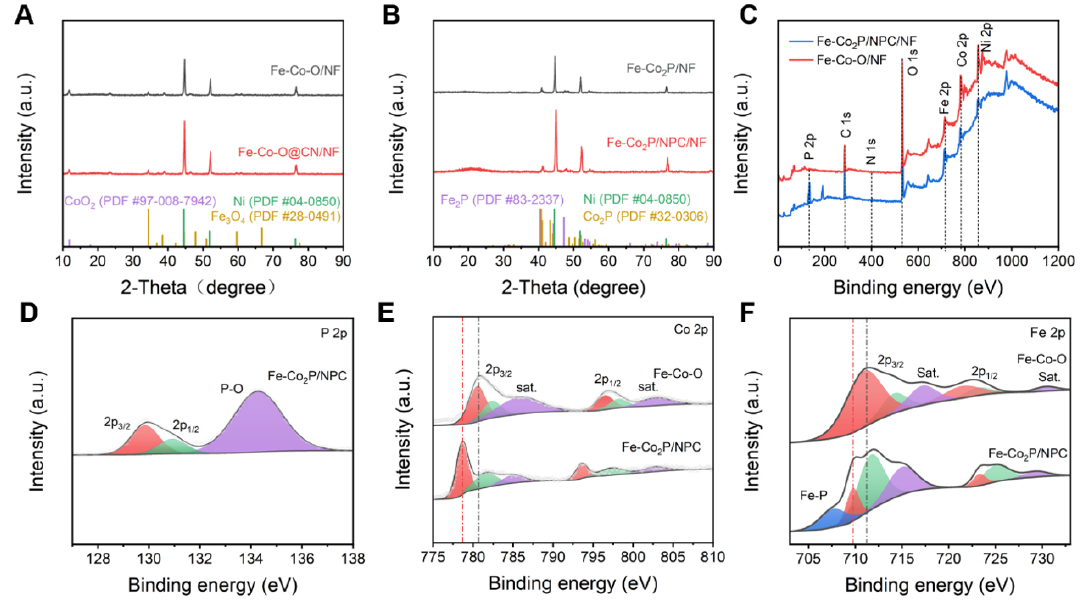
Figure 2. ( A , B ) XRD patterns of Fe-Co-O/NF, Fe-Co-O@CN/NF, Fe-Co 2 P/NF, and Fe-Co 2 P/NPC/NF. XPS results of Fe-Co-O and Fe-Co 2 P/NPC: ( C ) full spectra, ( D ) P 2p, ( E ) Co 2p, and ( F ) Fe 2p.